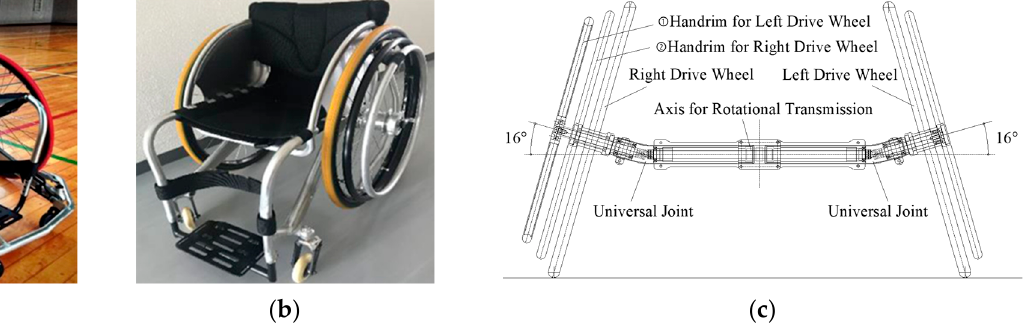
Figure 1. Competitive wheelchair with the dual hand-rim system: ( a ) right-hand drive with a camber angle, ( b ) left-hand drive without a camber angle, and ( c ) a double-ring drive shaft structure. Following is a description of straight-line operation of the wheelchair using one arm.